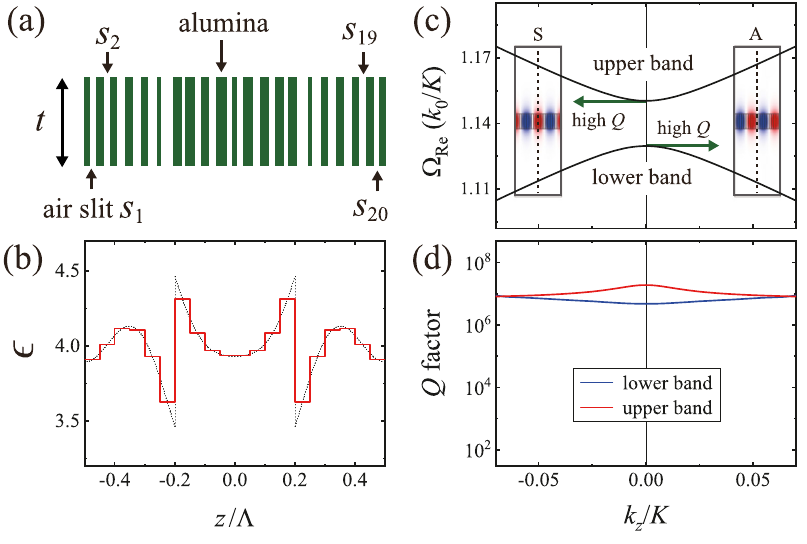
Figure 6: (a) Schematic of an alumina-air metasurfacewith t = 0 . 30 Λ .(b)Theeffective dielectric constant of the alumina-air meta- surface in the computational unit cell of size Λ . The dotted line represents the dielectric constant of the FCE MG2. Simulated disper- sion relations (c) and radiative Q factors (d) near the fourth stopband of the alumina-air